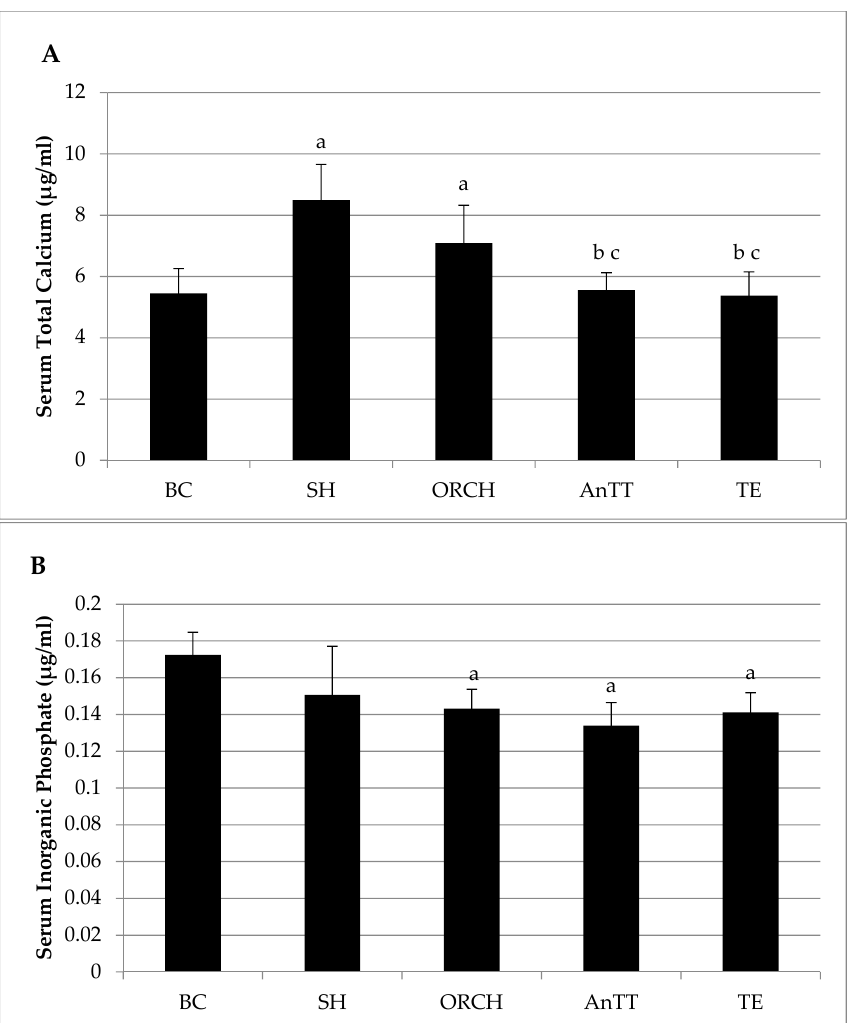
Figure 3. Post ‐ treatment serum total calcium ( A ) and inorganic phosphate level ( B ) in rats. The data are shown as mean with standard error of the mean. Letter ‘a’ indicates significant difference versus the baseline group; ‘b’ versus the sham ‐ operated group; ‘c’ versus the orchidectomized group. Abbreviation: AnTT, annatto tocotrienol ‐ supplemented group; BC, baseline control group; ORCH, orchidectomized group; SH, sham ‐ operated; TE, testosterone enanthate ‐ supplemented group. Bone calcium level was not significantly different between the SH and ORCH group ( p < 0.05). Both AnTT and TE group had significantly higher bone calcium level compared to ORCH group ( p < 0.05). Annatto tocotrienol treatment increased the calcium content more than testosterone enanthate ( p < 0.05) (Figure 4).